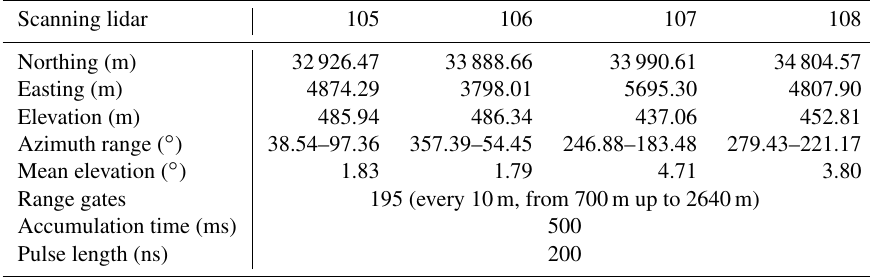
Table 1. Scanning lidar coordinates and details about the measurement settings. Scanning